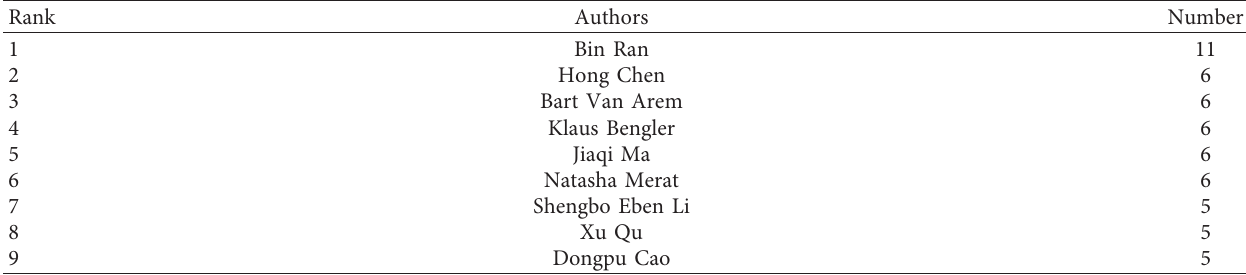
Table 4: The number of articles published by